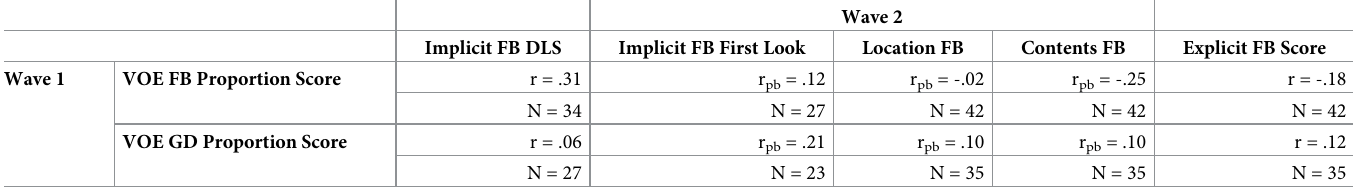
Table 2. Zero-order correlations between measures at Wave 1 and 2 in Experiment